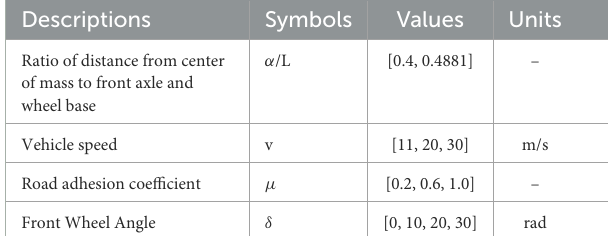
TABLE 2 Working condition parameters